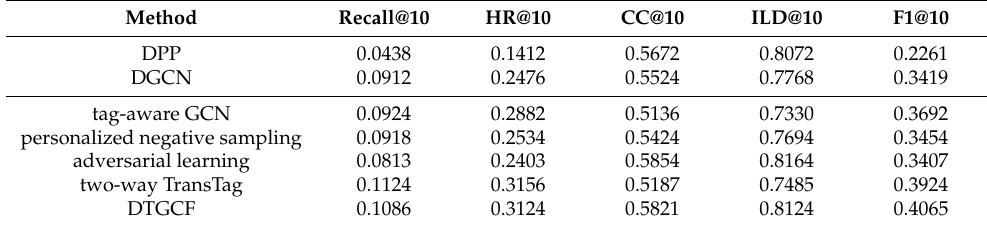
Table 3. Ablation study on the Movielens 10M dataset.